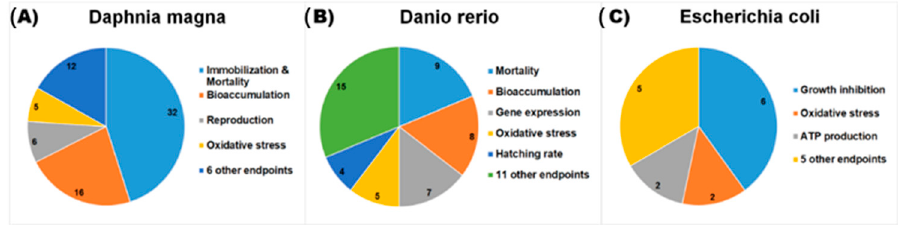
Figure 3. Number of studies on toxicity of nano-mixtures classified by endpoints for D. magna ( A ), D. rerio ( B ), and E. coli ( C